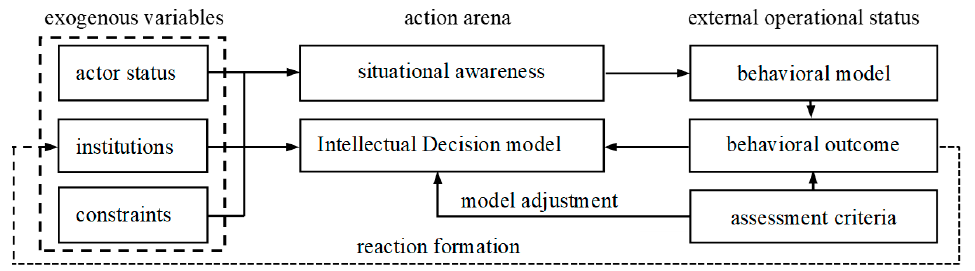
Figure 2. Institutional analysis and development (IAD) framework of farmers’ willingness to migrate to urban areas.